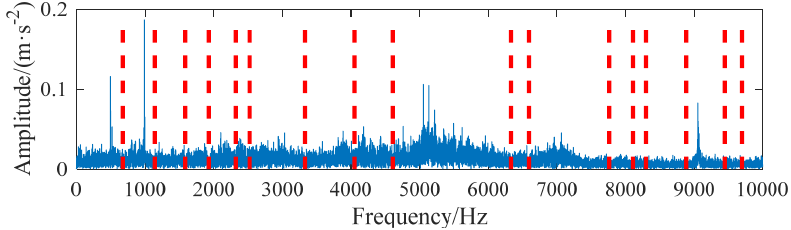
Figure 14. Schematic diagram of spectrum division of the envelope spectrum of the 2056th set of data.